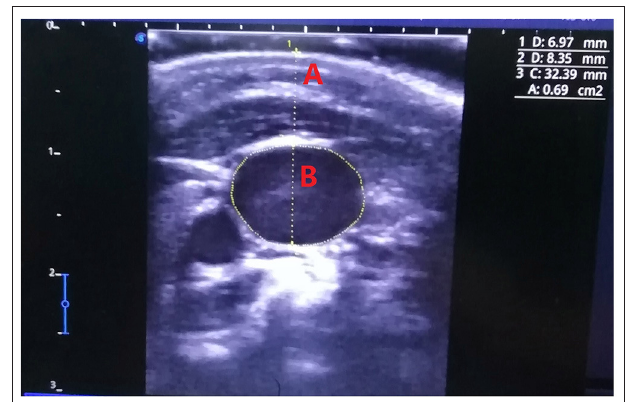
FIGURE 1 | Ultrasound measurement of internal jugular